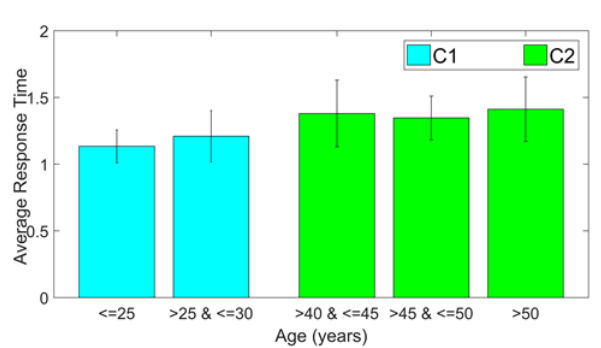
Fig. 7 Average response time for dDSST version 2